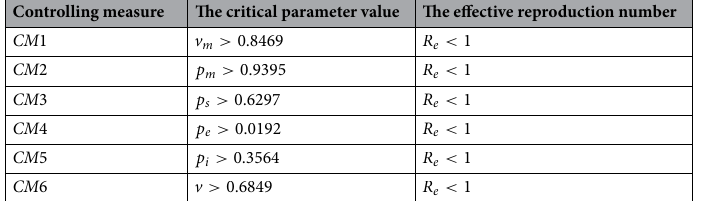
Controlling measure